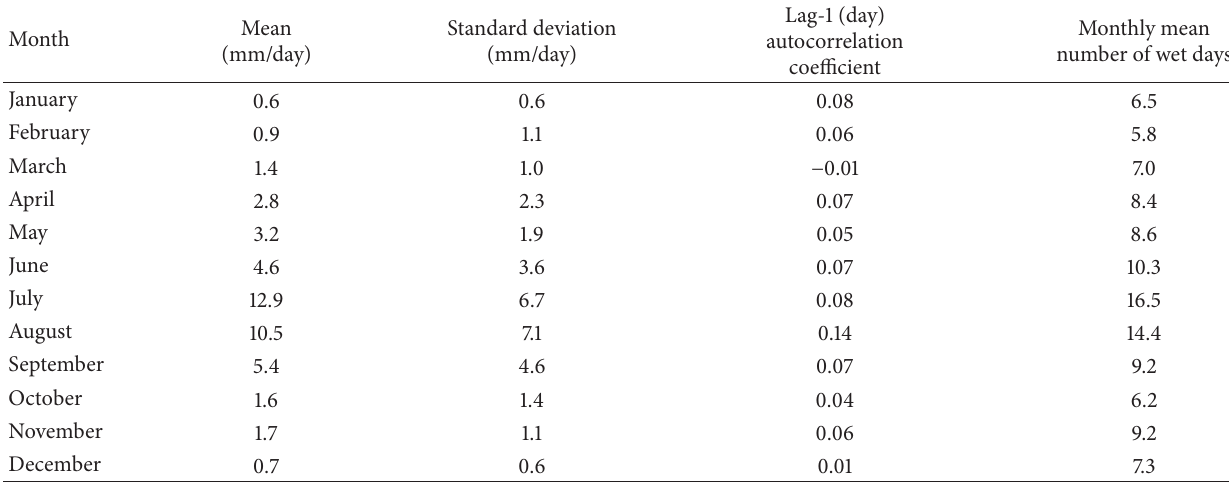
Table 1: Monthly statistics of daily rainfall at the Seoul weather station.